Question: Write a single sentence explaining what this figure depicts.
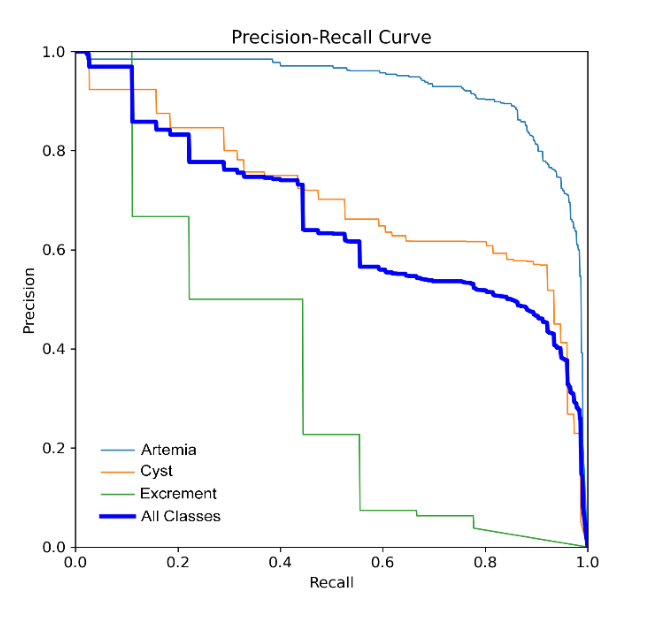
Answer: YOLOv8 Precision - Recall curve